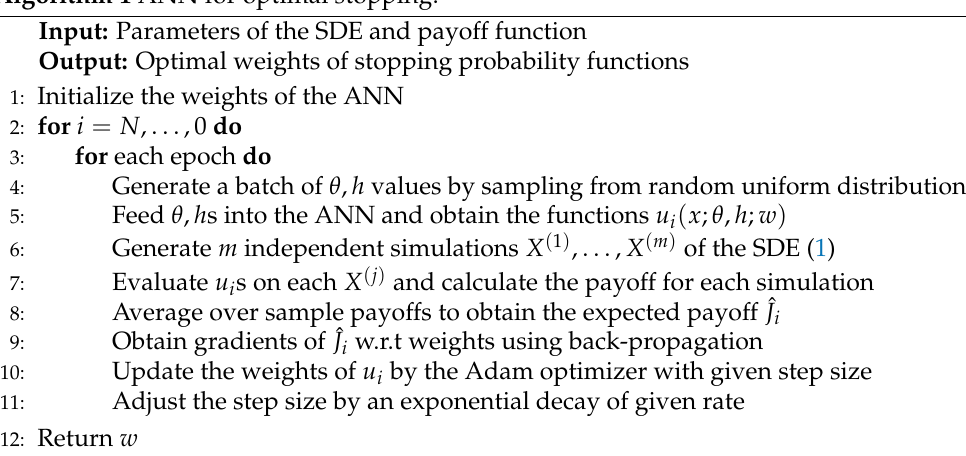
Algorithm 1 ANN for optimal